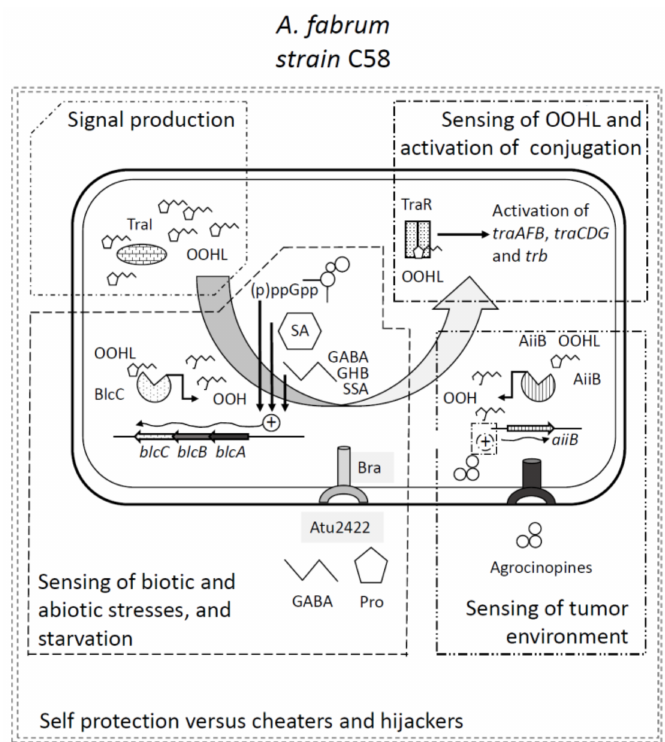
Figure 2. Integrated view of the quorum-sensing and quorum quenching functions in strain C58 and their involvement in the sensing of environmental parameters. The production of the QS signal OOHL results from the activity of TraI. The sensing of the signal by the sensor TraR depends on quorum quenching (QQ) activities of both the lactonases BlcC and AiiB. BlcC production is activated by various signals of environmental origins, such as the alarmones (p)ppGpp, the plant defense hormone salicylic acid, and the stress-related molecule GABA. This later enters the cell via the Atu2422 periplasmic binding protein coupled to the Bra transporter. This uptake is antagonized by molecules such as proline. The GABA to proline ratio varies drastically in healthy and crown gall tumor tissues. Salicylic acid concentration responds to mostly the presence of plant pathogens. The alarmone (p)ppGpp is involved in the regulation of the expression of multiple bacterial genes—including those of the blcABC operon—under starvation conditions. AiiB production is induced by the agrocinopines that also induce the conjugal transfer of the Ti plasmid. The TraI/TraR and TraM/BlcC/AiiB system defines an integrated and complex “go/no go system”, self-protected from cheaters and hijackers (see text) that finely controls the biologically costly transfer of the Ti plasmid in response to multiple environmental cues. GABA: gamma-aminobutyric acid, SA: salicylic